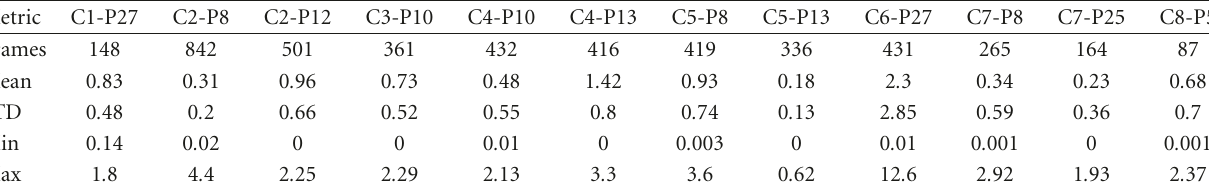
Table 7: 3D localisation statistical results.